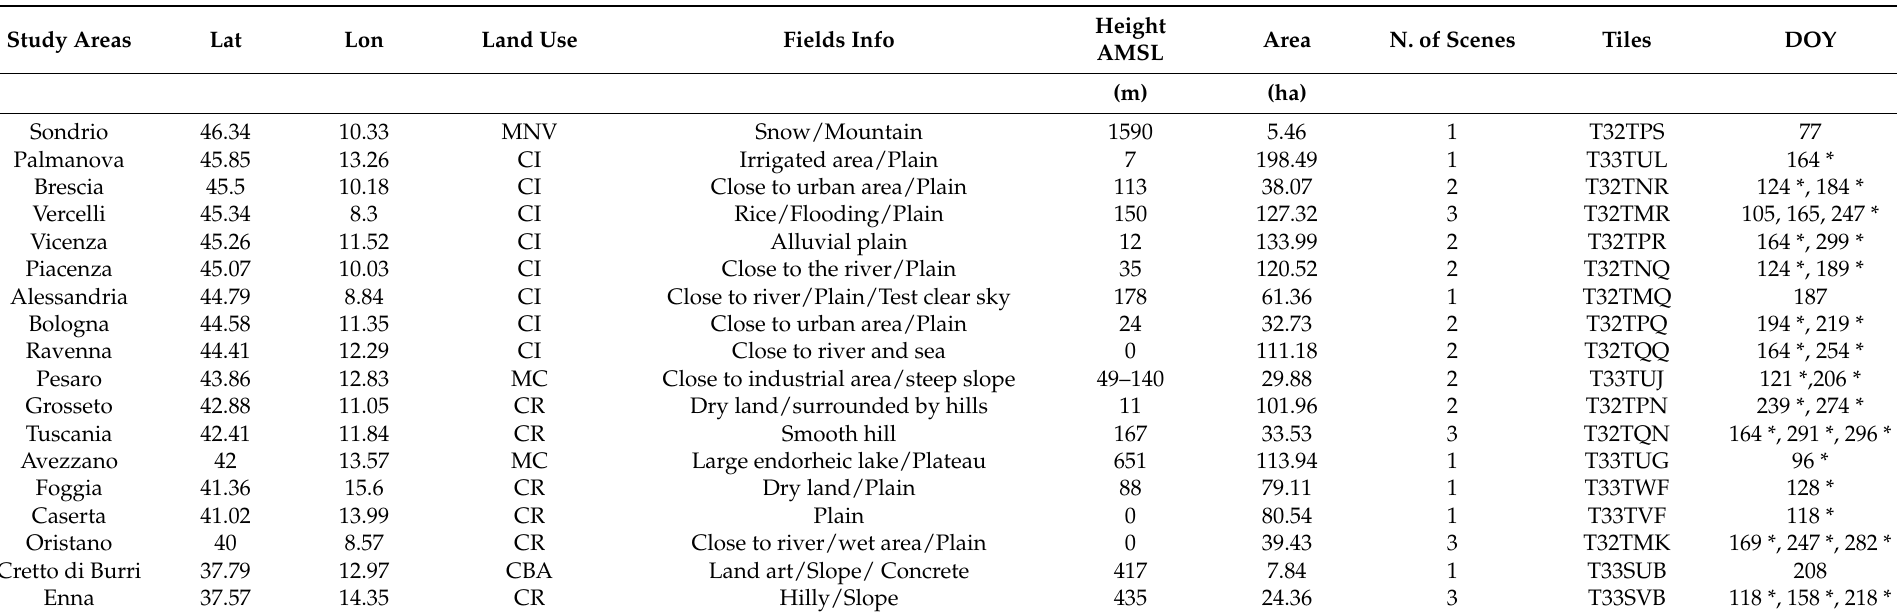
Table 1. Main characteristics of the study areas and the number of scenes selected for each field. Land use classification is based on the European Space Agency-Climate Change Initiative (ESA-CCI) Land Cover definition (MNV = Mosaic Natural Vegetation; CI = Cropland Irrigated; MC = Mosaic Cropland; CR = Cropland Rainfed; CBA = Consolidated bare areas). Height AMSL = Height Above Mean Sea Level; DOY = Day-Of-Year; * for cloud